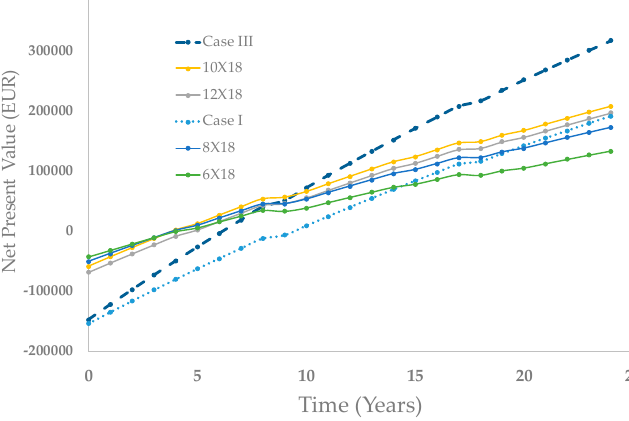
Figure 6. The Net Present Value for the alternatives.